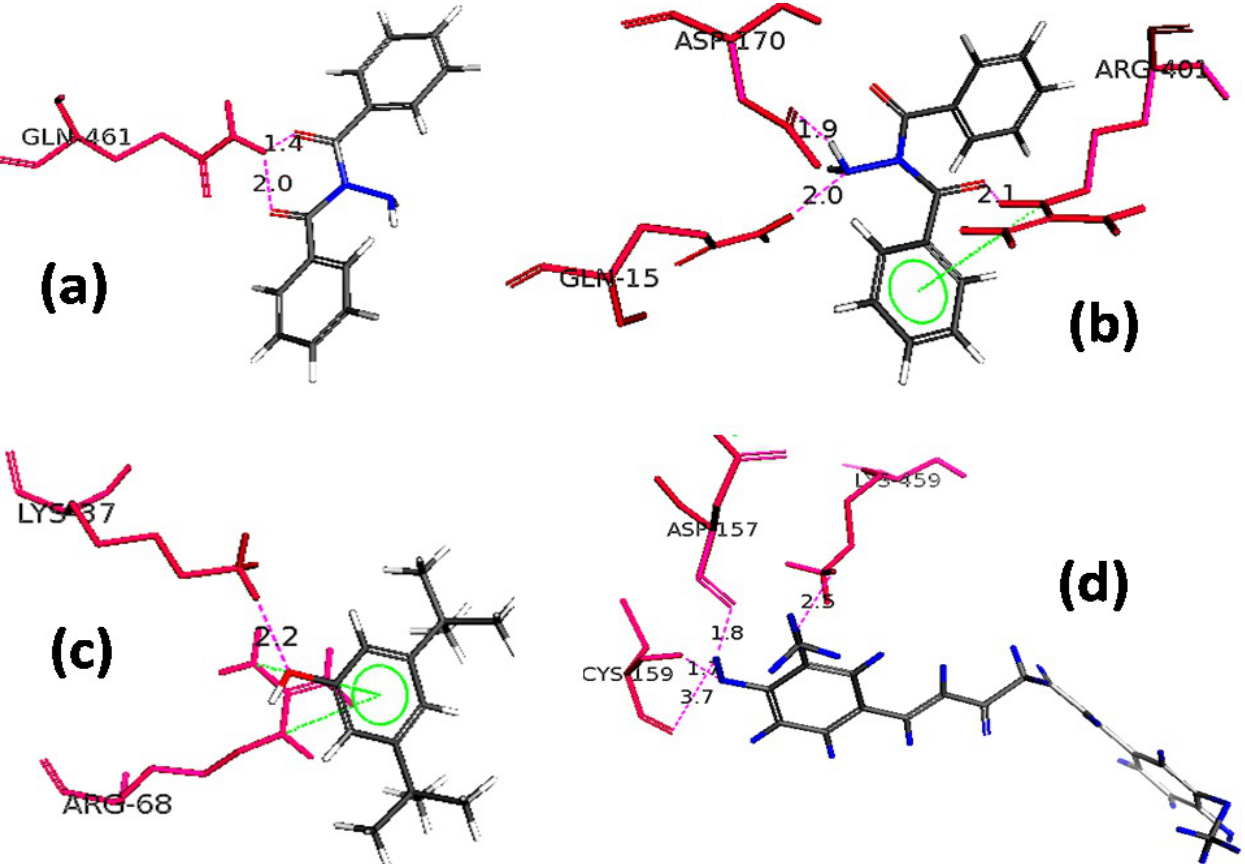
Figure 4. Close-up depiction of lowest energy three-dimensional (3-D) docking poses of ( a ) dibezoylhydrazine with COX-2, ( b ) dibezoylhydrazine with 5-LOX, ( c ) 7-acetyl-2-hydroxy-2-methyl-5-isopropylbicyclo [4.3.0] nonane with 5-LOX, and ( d ) 6-Octadenoic acid, methyl ester with COX-2. Bond distances in Ǻ were shown by the dotted line. Table 5. Binding energies of compounds docked with COX-2 and 5-LOX.